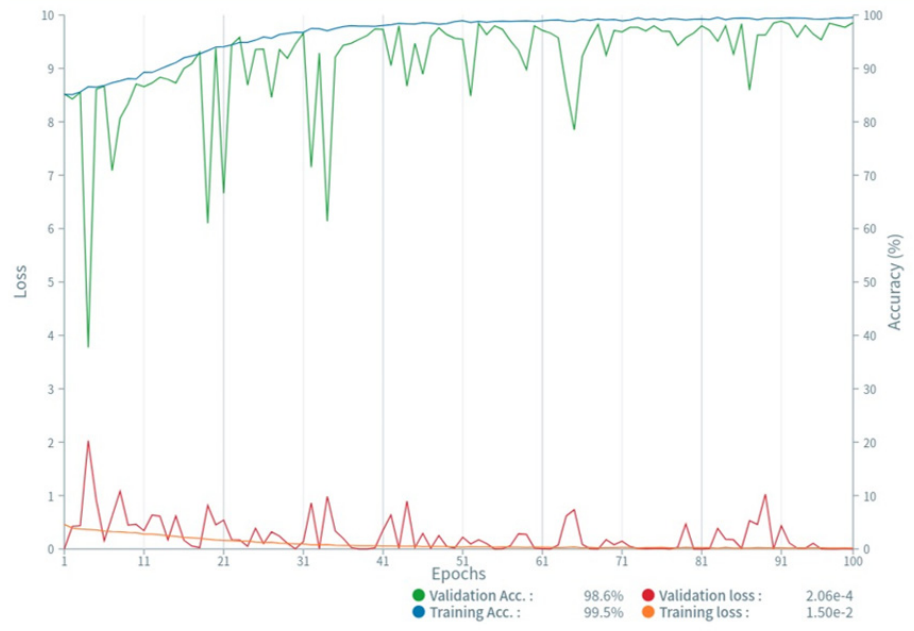
Figure 5. Accuracy and loss of training and validation data. The plots of training loss and validation loss decreased to a stable point, with a small gap between